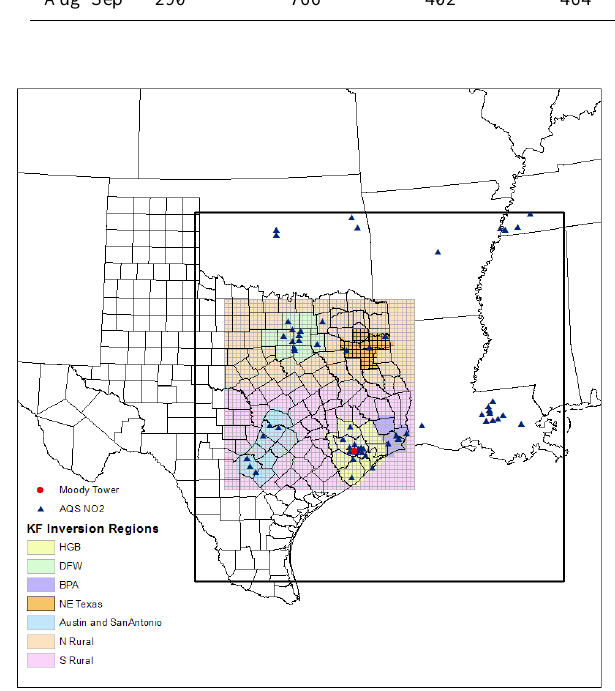
Fig. 1. 12km CAMx modeling domain for eastern Texas (black square), inversion regions (shaded), ground AQS NO 2 monitoring sites (blue triangles), and Moody Tower (red